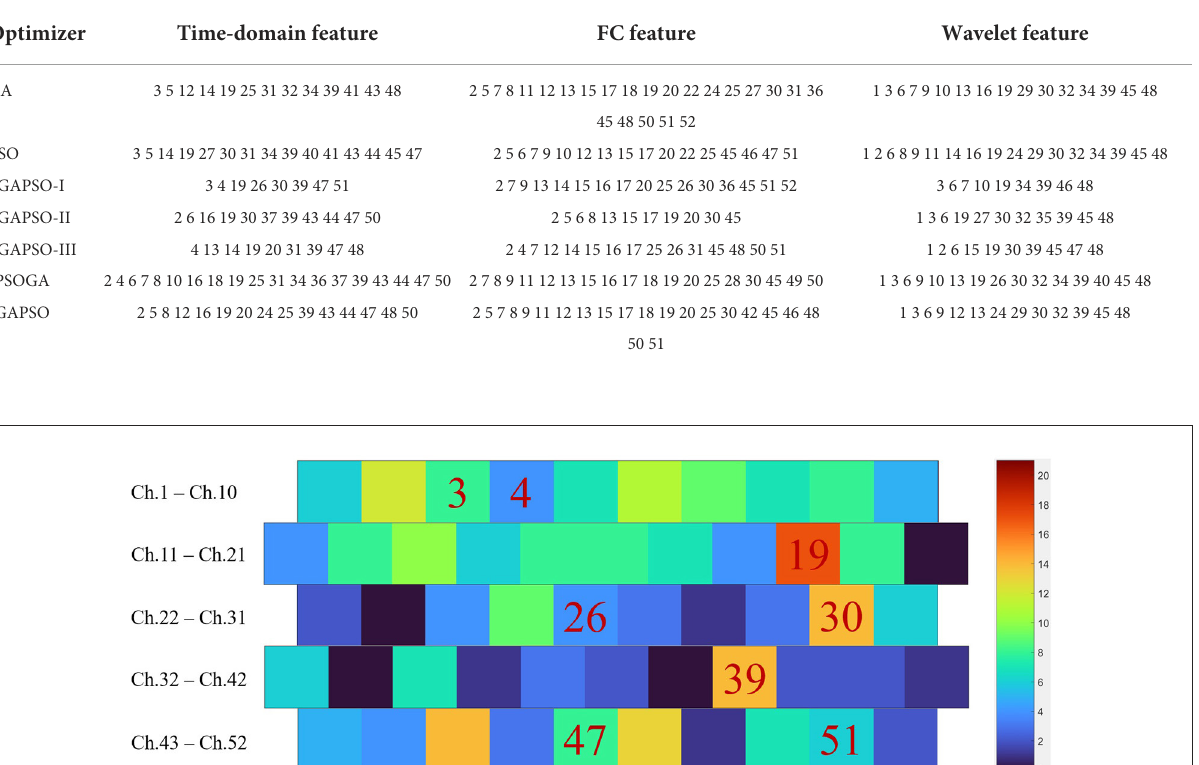
TABLE 2 The specific channels corresponding to the best results obtained by different features and optimizers.